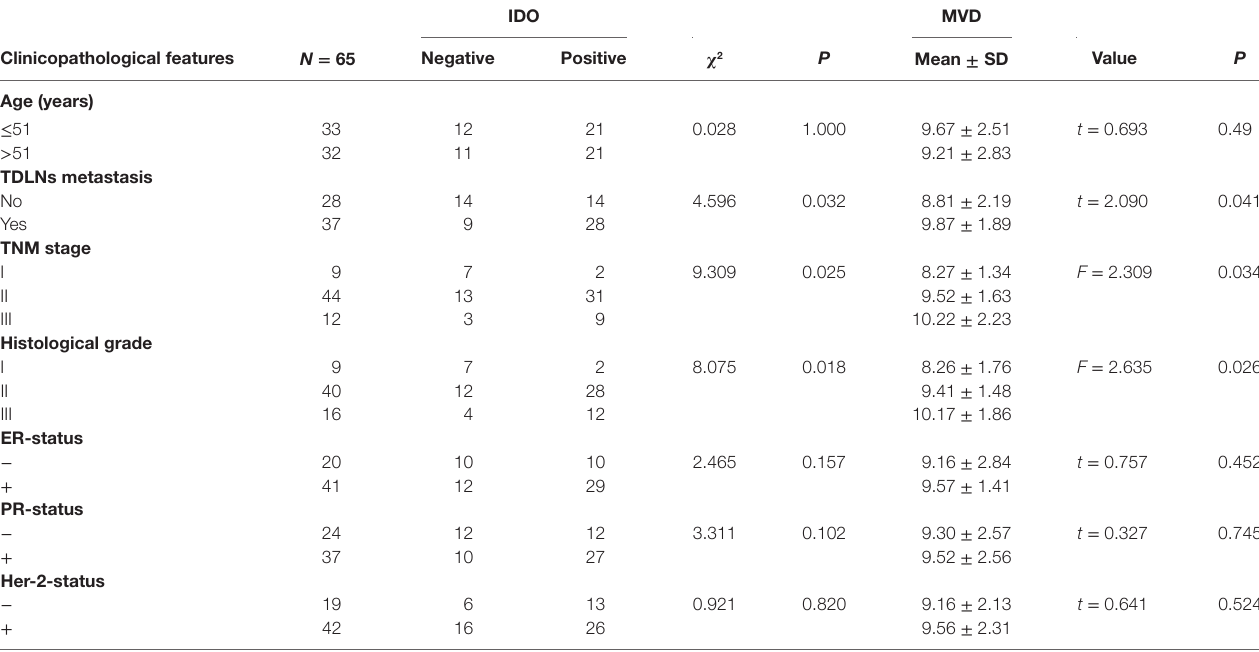
TaBle 2 | The association between indoleamine 2,3-dioxygenase (IDO) expression, microvessel density (MVD)-CD105 level and clinicopathological features. iDO MVD clinicopathological